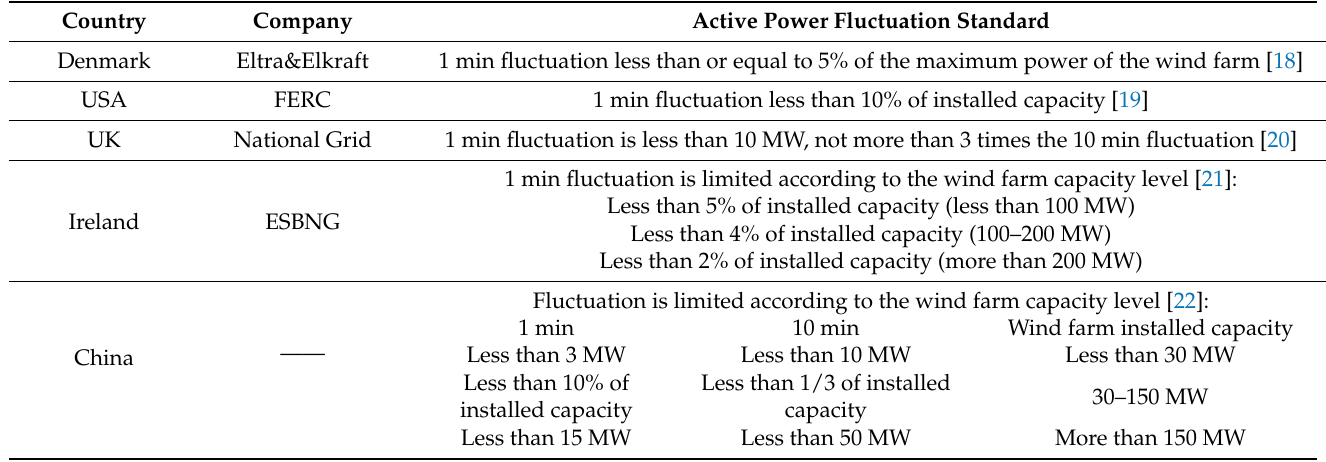
Table 1. Fluctuation